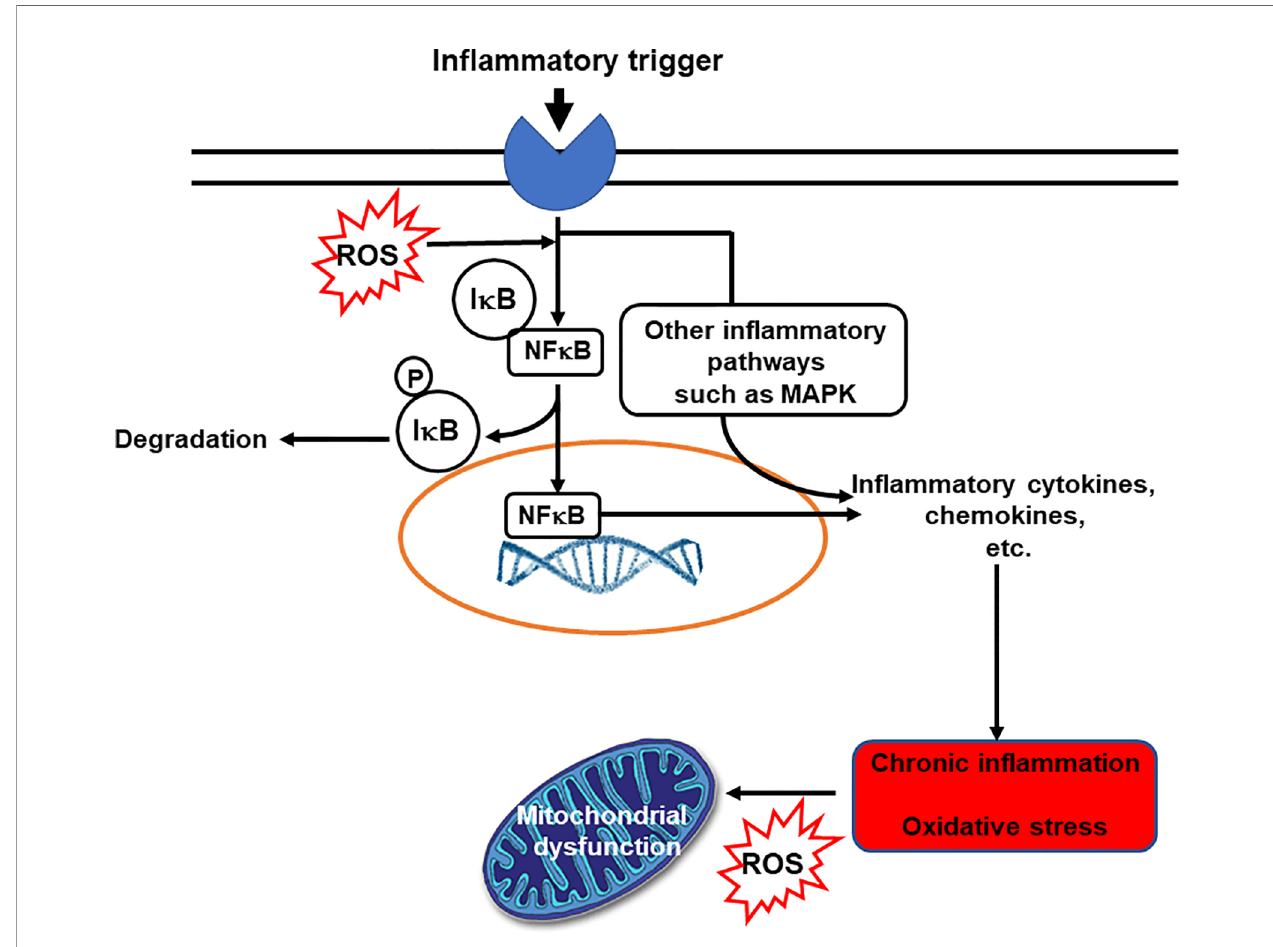
FIGURE 2 | The bidirectional links between in fl ammation and oxidative stress. Reactive oxygen species (ROS) can act as in fl ammatory trigger initiating in fl ammation. On the other hand in fl ammation induces oxidative stress. I k B, inhibitory subunit of NF k B; MAPK, mitogen-activated protein kinase; NF k B, nuclear factor kappa-light- chain-enhancer of activated B cells; P, phosphate; ROS, reactive oxygen